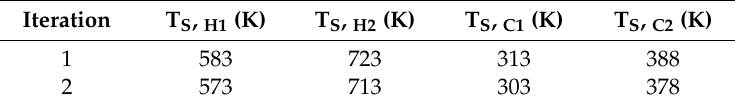
Table 11. Uncertain parameters for the points